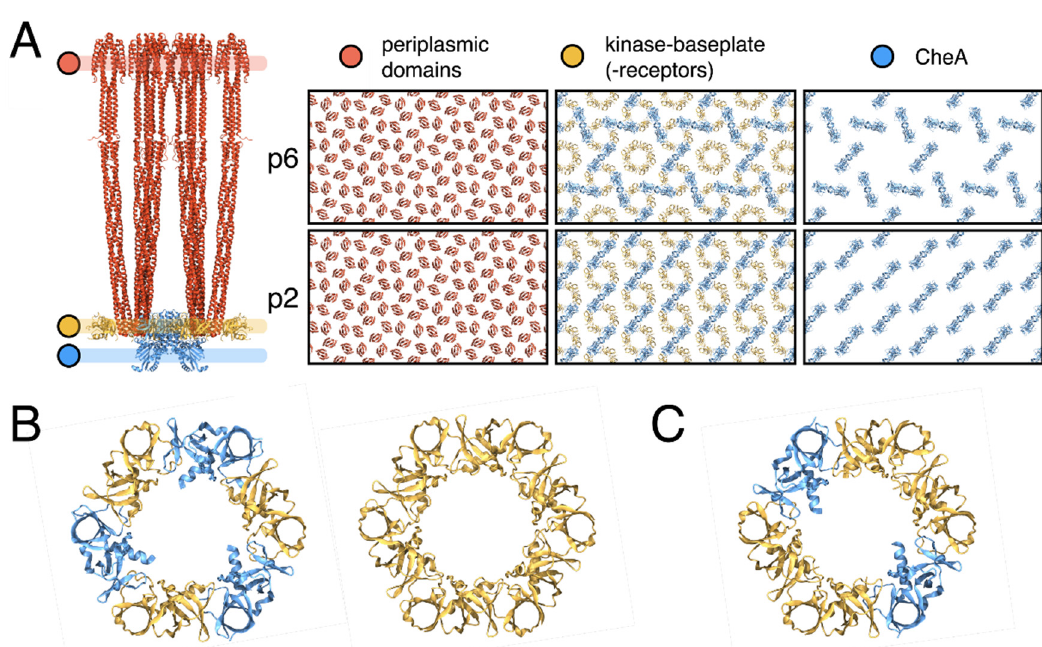
Figure 4. Structural features of p6 and p2 chemosensory array architectures. ( A ) All-atom model of the CSU (left) including flanking CheW molecules. Regions corresponding to the periplasmic domains of receptor proteins, kinase baseplate and CheA.P4 are demarcated in orange, yellow and blue, respectively. The corresponding regions in both the p6 and p2 array architectures are presented to the right, showing the near-identical receptor organisation and structural differences in the baseplate region. ( B ) The (W) 6 and (A.P5/W) 3 rings of CheA and CheW present in the p6 array architecture. ( C ) The (A.P5/W/W) 2 ring of CheA and CheW present in the p2 array architecture.